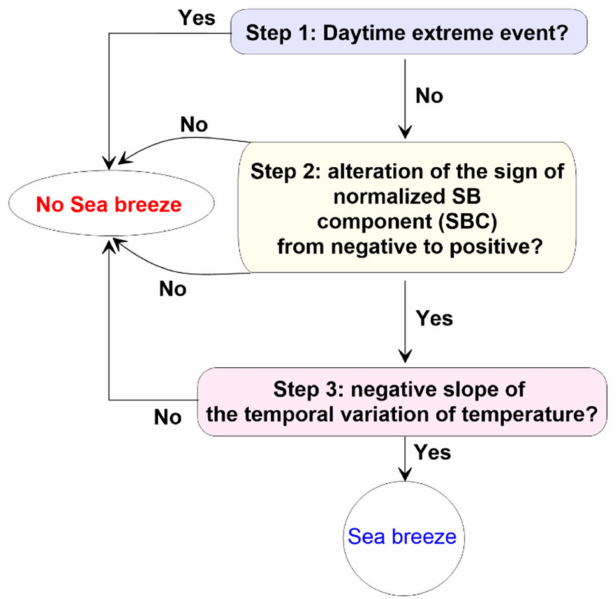
Figure 2. Flow chart for the SCSBC sea-breeze identification